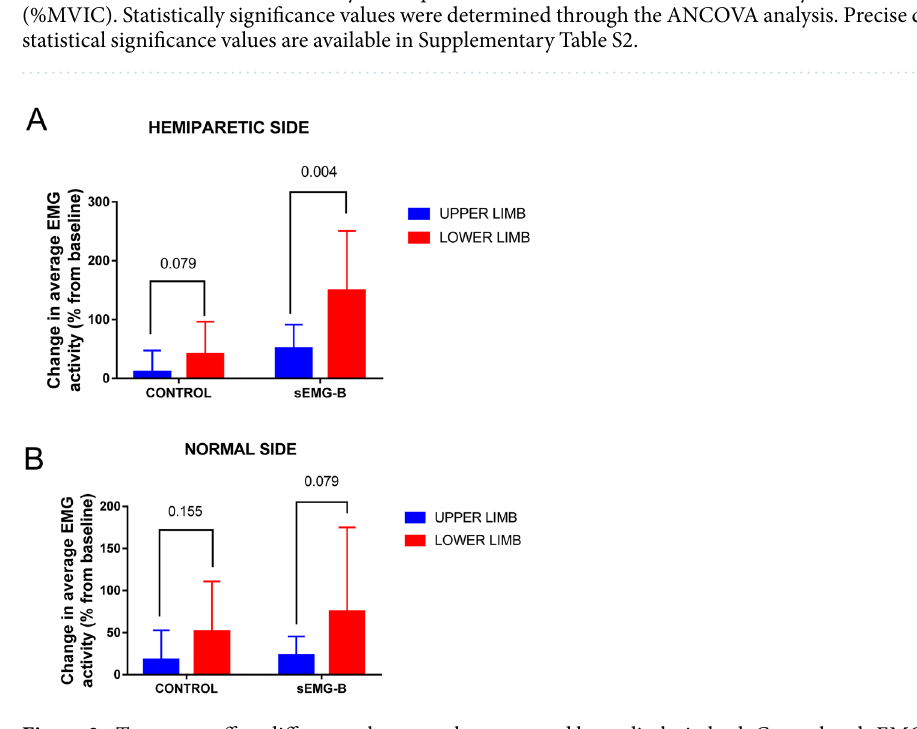
Figure 3. Treatment effect differences between the upper and lower limbs in both Control and sEMG-B groups. Differences were analysed by ANCOVA